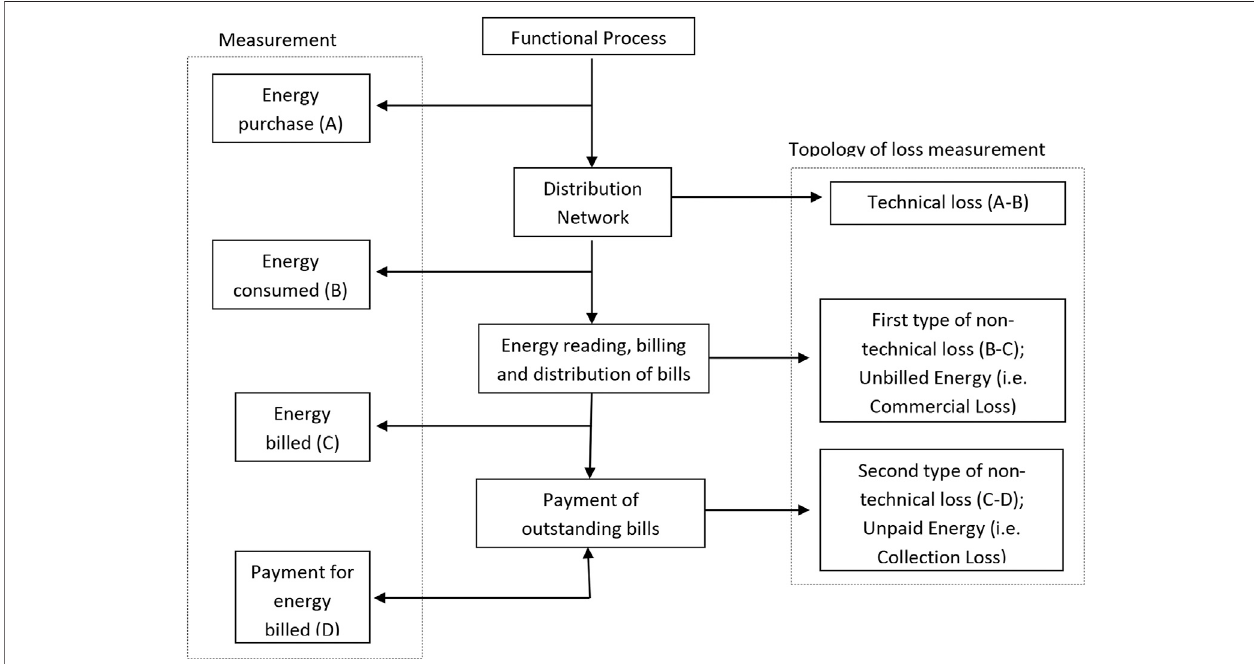
FIGURE 1 | Functional process, measurements, and topology of loss measurements of ATC&C losses (Kirankumar, 2013).